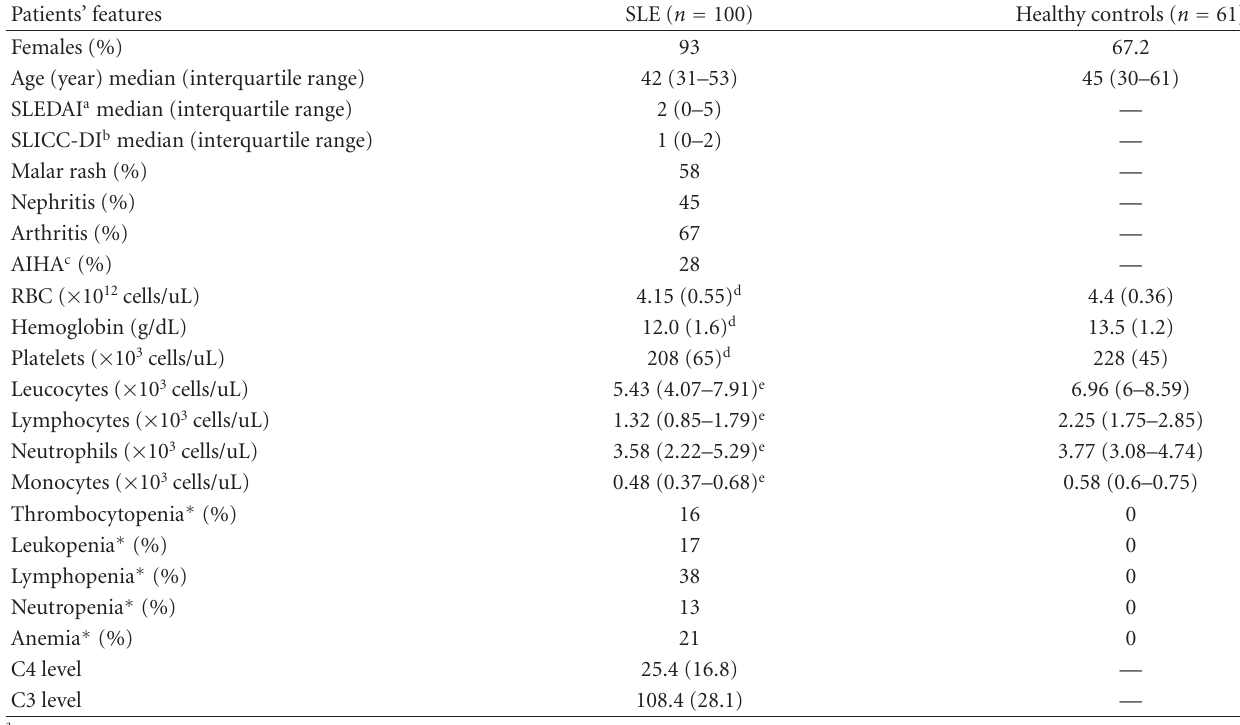
a SLEDAI: systemic lupus erythematosus disease activity index.